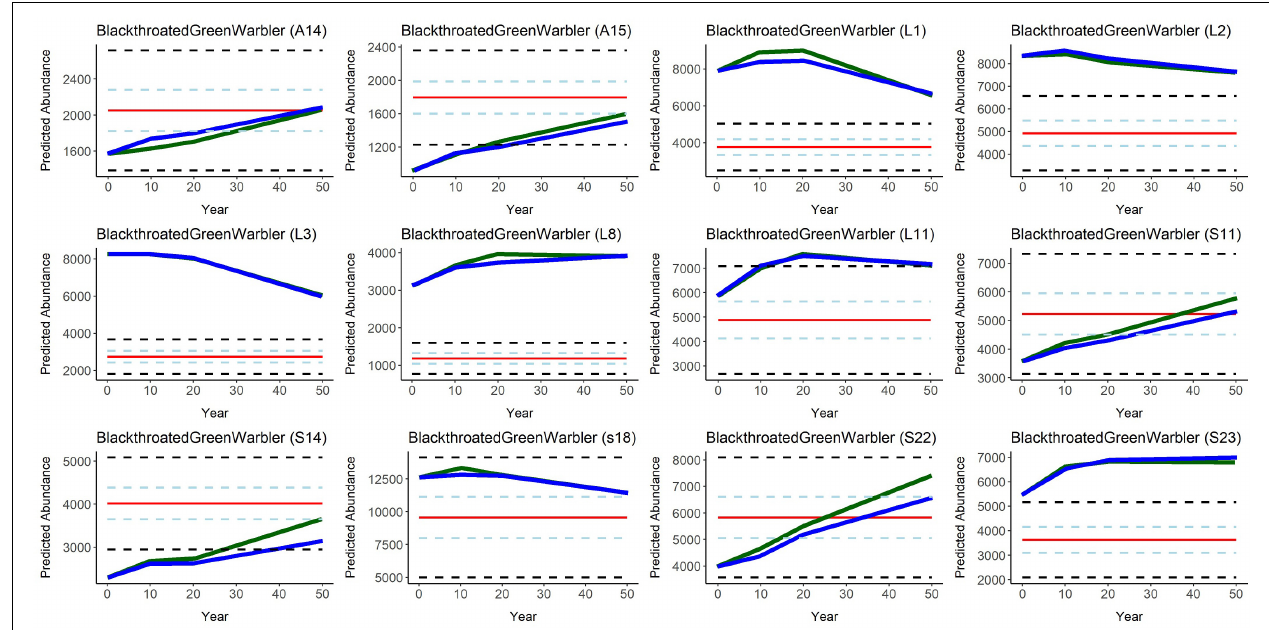
FIGURE 5 | Predicted Black-throated Green Warbler abundance over time (year 0-50, where year 0 = 2016) in all 12 Forest Management Units in the Al-Pac Forest Management Area, under two scenarios: (1) the Preferred Forest Management Scenario (PFM) that included harvest deferral within caribou habitats (green line); and (2) the Ecosystem-Based Management/Natural Disturbance Model Scenario (EBM) without harvest deferral (blue), relative to the predicted Natural Range of Variation (NRV) in Black-throated Green Warbler abundance in the absence of human footprint. Red line = mean predicted Black-throated Green Warbler abundance per Forest Management Unit in the NRV Scenario. Light blue dashed lines = 50% confidence intervals for mean predicted Black-throated Green Warbler abundance in the NRV Scenario. Black dashed lines = 95% confidence interval estimates in the NRV Scenario. SDMs predicted that Black-throated Green Warbler densities were highest in very old deciduous and mixed-wood stands ( > 80 years old) and average deciduous and mixed-wood forest age increased in most FMUs over 50 years in the Patchworks simulations, while average deciduous and mixed-wood forest age was reduced by simulated fires in the NRV